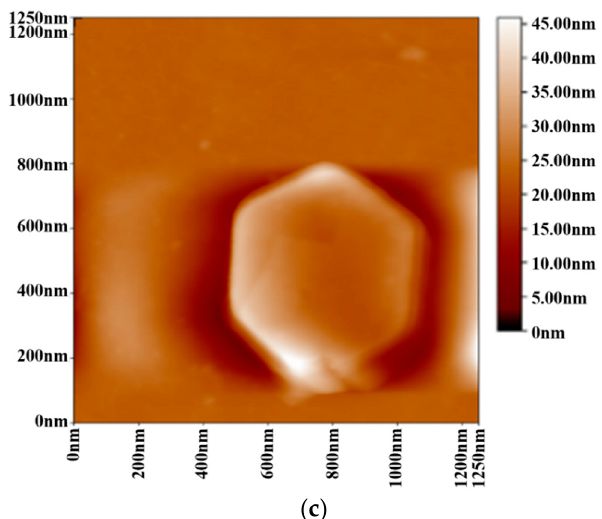
Figure 4. ( a ) Scanning electron microscopy (SEM) image of α -ZrP; ( b ) Transmission electron microscopy (TEM) image of exfoliated α -ZrP nanoplatelets; ( c ) Atomic Force Microscopy (AFM) image of exfoliated α -ZrP nanoplatelets.